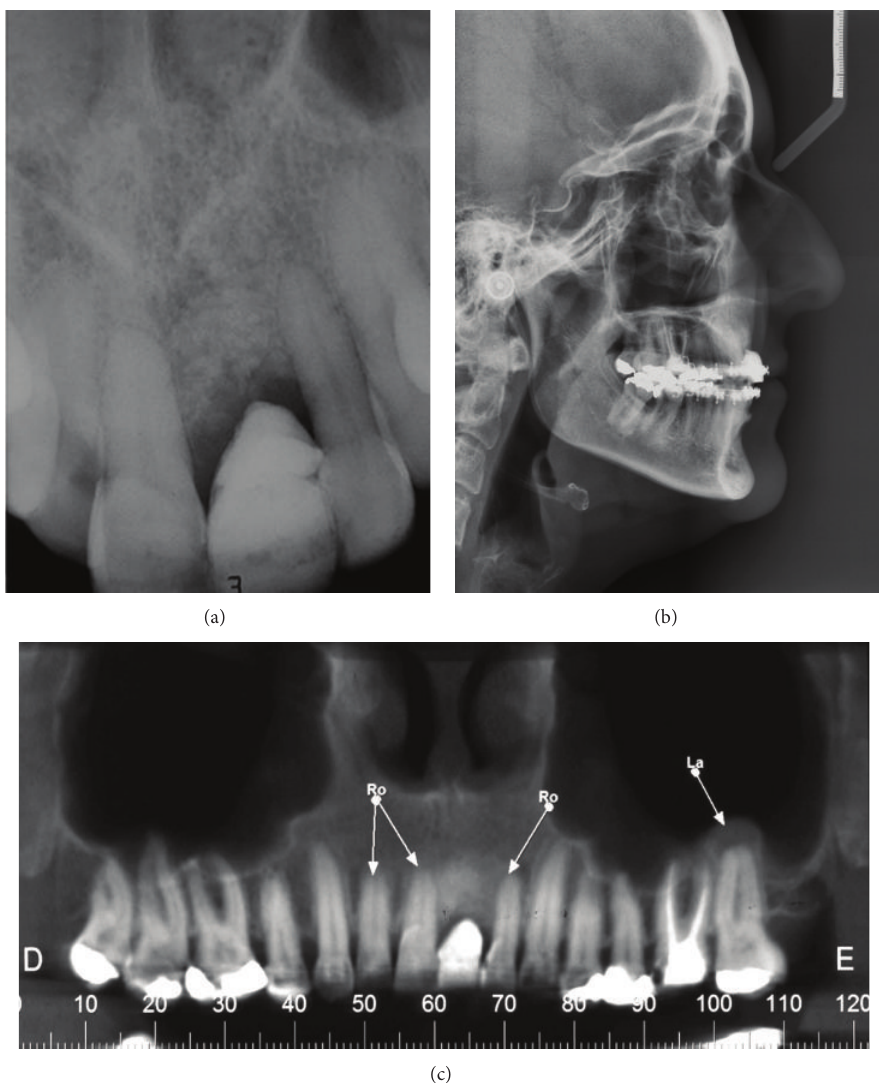
Figure 7: Periapical, cephalometric, and panoramic radiography after orthodontic movement showing alveolar bone augmentation allowing implant